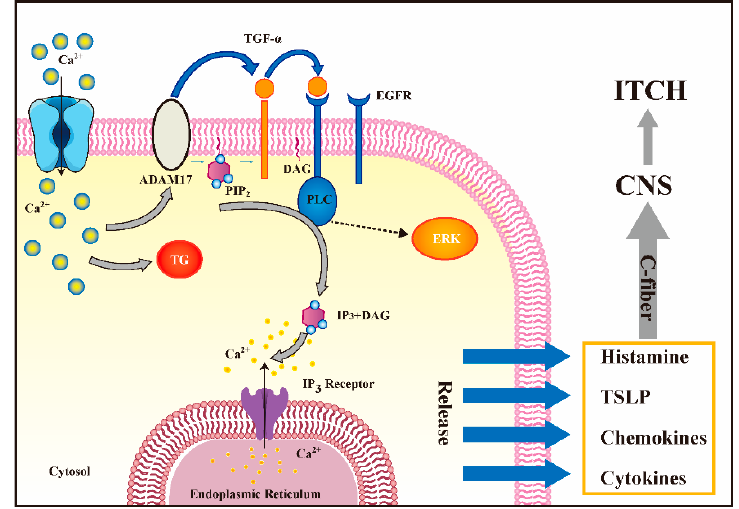
Figure 3. The role of TRPV3 in itch signal and cell proliferation. ERK, extracellular signal-regulated kinase; ADAM17, metalloprotease ADAM17; DAG, diacylglycerol; IP3, inositol trisphosphate; PIP2, phosphatidylinositol(4,5)bisphosphate; PLC, phospholipase C; CNS, central nervous system; TSLP, thymic stromal lymphopoietin [34].